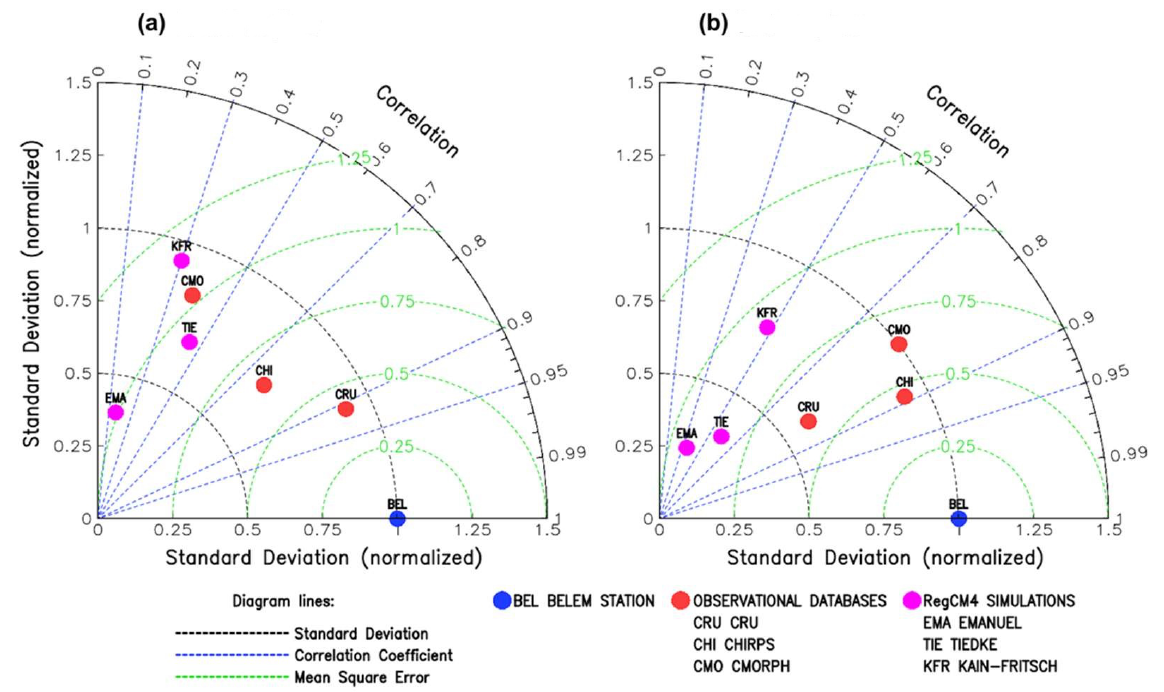
Figure 7. Taylor diagram of observed (CRU, CHIRPS, and CMORPH, circles in red) and simulated (EMA, TIE, and KFR, circles in magenta) PREC for the ( a ) RAINY and ( b ) DRY regimes.